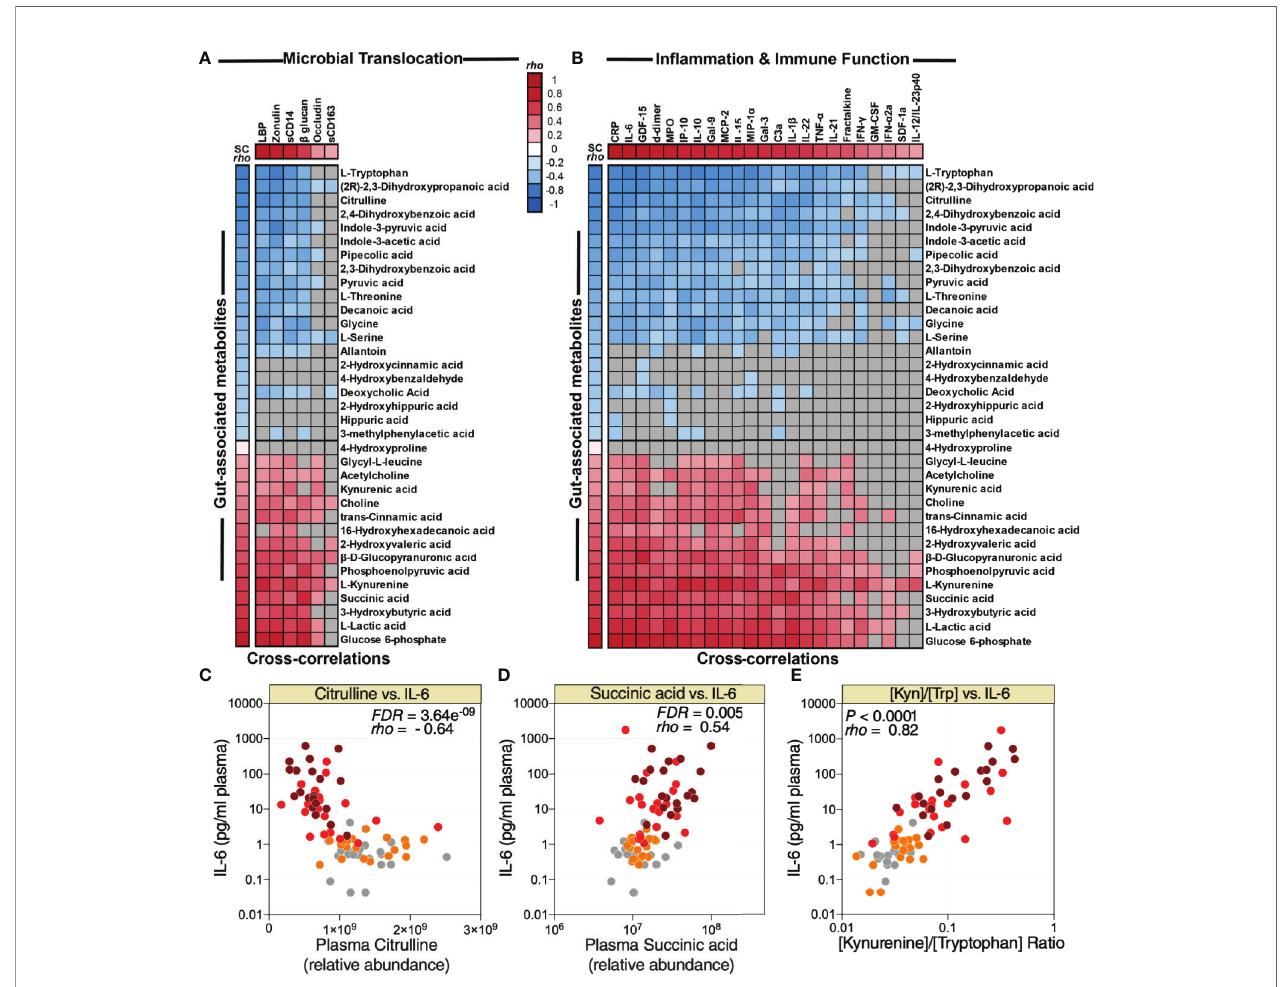
FIGURE 4 | Metabolic markers of intestinal dysfunction are linked to microbial translocation and systemic in fl ammation. Correlation heat-maps depicting the correlations between COVID-19-modulated, gut-associated metabolites, and (A) markers of tight junction permeability and microbial translocation or (B) markers of in fl ammation and immune dysfunction. SC rho = coef fi cient of correlation with COVID-19 severity. Red-colored correlations = signi fi cant positive correlations with FDR<0.05, blue-colored correlations = signi fi cant negative correlations with FDR<0.05, gray-colored correlations = non-signi fi cant (FDR>0.05). (C, E) Examples of the correlations between citrulline and IL-6 (C) , succinic acid and IL-6 (D) , or [Kyn/Trp] ratio and IL-6 (E) . Spearman ’ s rank correlation tests were used for statistical analysis. FDR was calculated using Benjamini-Hochberg